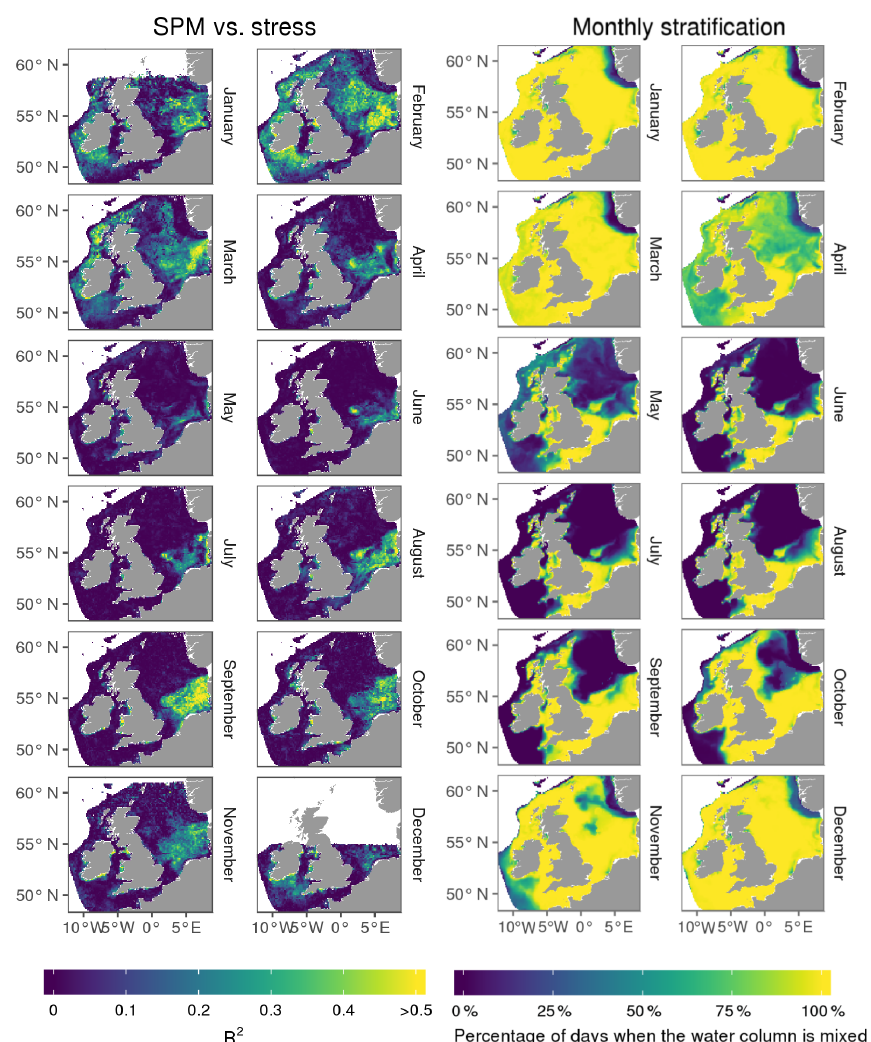
Figure 4. Monthly stratification and the relationship between bed shear stress and SPM. The left panel shows the monthly correlation coefficient between mean monthly SPM and bed shear stress in each 0 . 125 ◦ × 0 . 125 ◦ grid point between 1997 and 2017. The right panel shows the percentage of days when the water column is mixed, with the water column classified as mixed when the difference between the sea surface and seafloor temperature is less than 0.5 ◦ C. White areas in the region are those with insufficient satellite coverage for